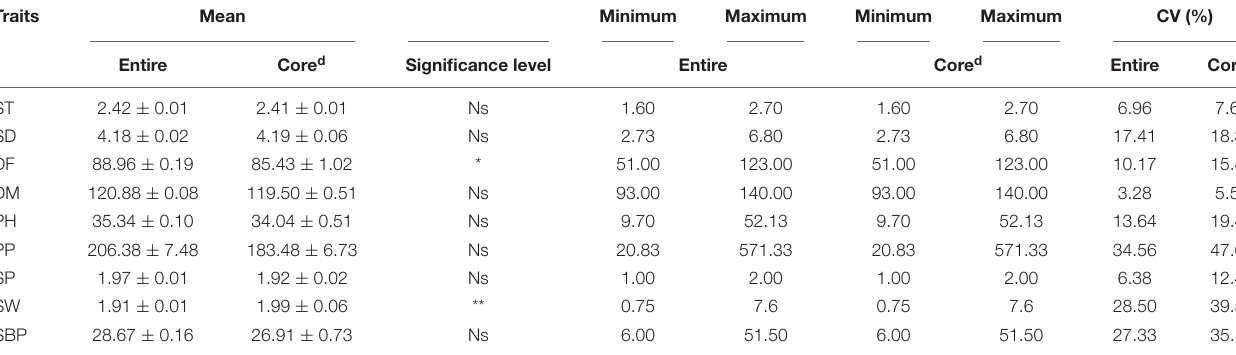
TABLE 4 | Mean, range, and CV in entire and core set of lentil germplasm. Traits Mean Minimum Maximum Minimum Maximum CV (%) Entire Core d Significance level Entire Core d Entire Core